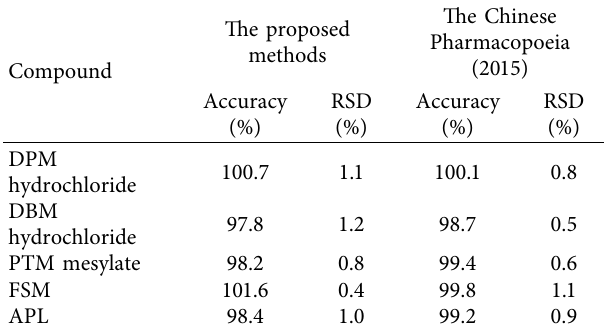
Table 5: The results obtained by the proposed methods and the reference methods.